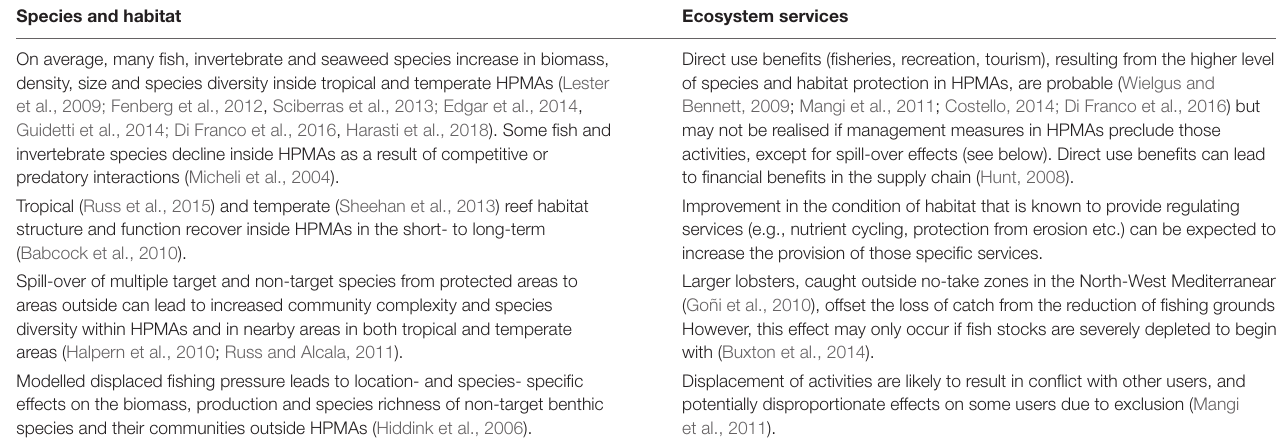
TABLE 1 | Examples of key ecological effects and associated socio-economic effects attributed to highly protected marine areas (HPMAs, see text for details). Species and